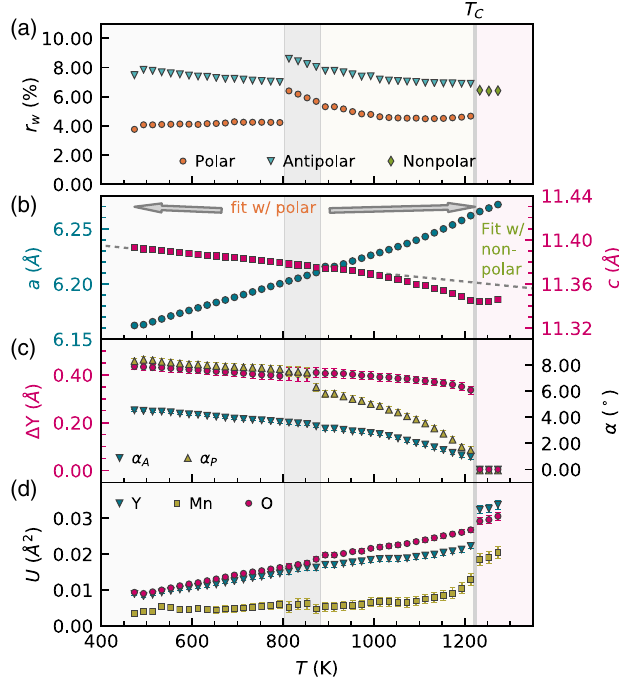
FIG. 2. Average structure refinements of YMnO 3 . (a) Fitting residuals r of the high-symmetry NP and low-symmetry P and w AP models to I ð Q Þ , where Q is the reciprocal space vector. The gray vertical line at 1223 K indicates the Curie temperature T C above which the high-symmetry nonpolar structure can be inferred from the Bragg reflections. The gray shaded area between 800 K and 880 K separates low- and intermediate- temperature regions. (b) Lattice parameters a and c ; (c) Y corrugation Δ Y, apical tilt angle α , and planar tilt angle α ; A P and (d) isotropic atomic displacement parameters U — all ob- tained from fitting the P ground-state model below T and the C high-symmetry NP structure above T to the reciprocal space C neutron time-of-flight data. (Representative Rietveld fits with the polar, antipolar, and nonpolar models are shown in Figs. S3 – S5 of the Supplemental Material